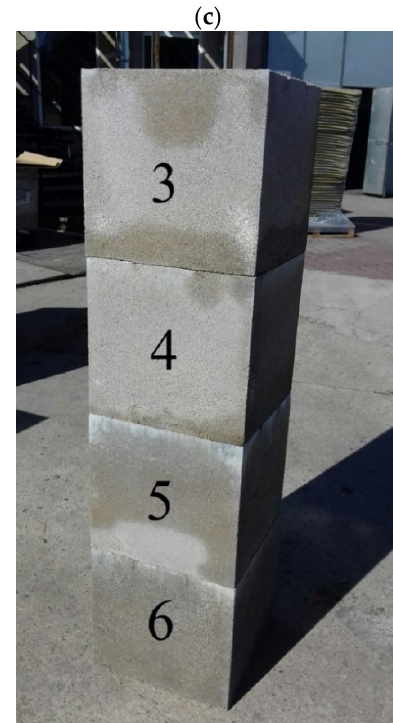
Figure 2. Photos of: ( a ) perlite (1), ( b ) leca concrete block (2) and ( c ) perlite concrete blocks (3–6) with different bulk densities.